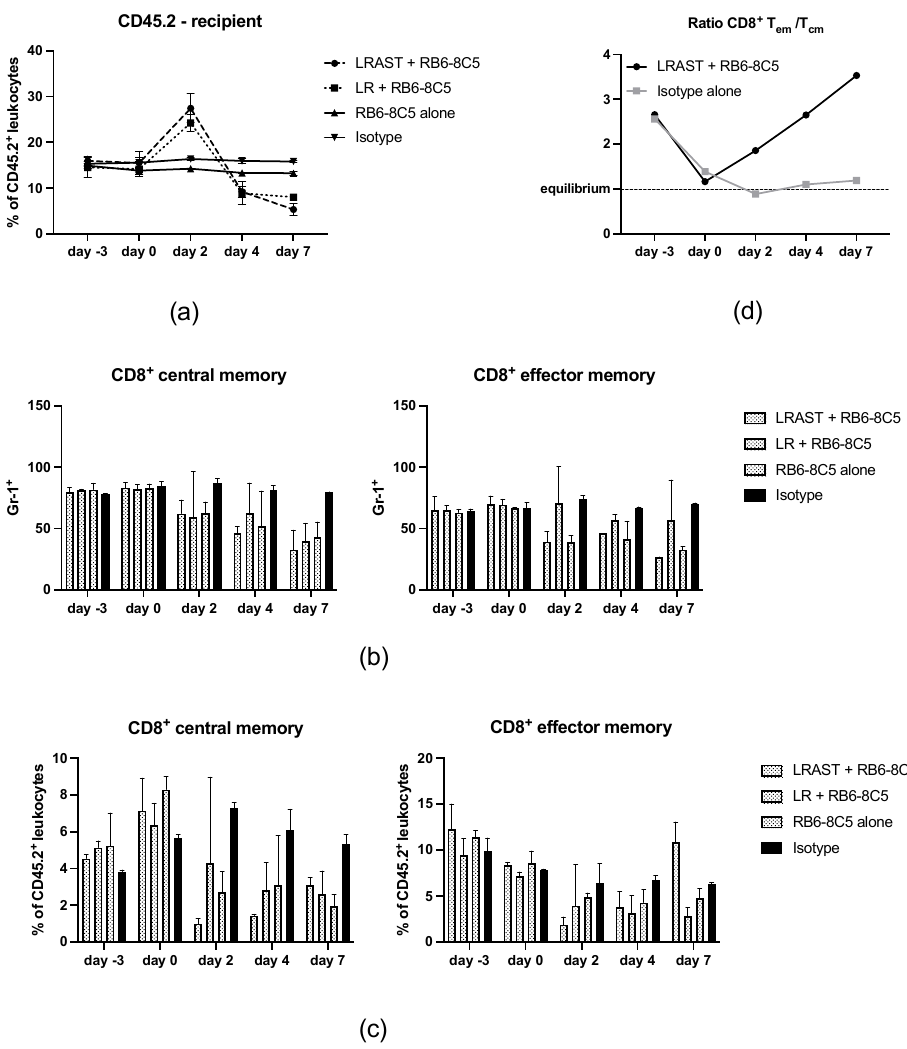
Figure 5. Effect of RB6-8C5 administration on CD8 + memory T cells . ( a ) Frequency of CD3 + CD8 + cells in % of CD45.2 + leukocytes (in the following referred to as CD8 + cells), assessed by flow cytometry on days -3, 0, 2, 4, and 7 from the blood of mice in different treatment groups (as indicated in the picture). ( b ) Frequency of Gr-1 + CD8 + central (left) and effector (right) memory T cells from the same animals as in ( a ). ( c ) CD8 + central (left) and effector (right) memory T cells in % of CD45.2 + leucocytes form the same animals as in ( a ). ( d ) Ratio of CD8 + effector and central memory T cells (T em /T cm ) calculated from results depicted in (c). A ratio equal to 1 represents an equilibrium state with identical amounts of both memory T cell subsets. ( a – d ) n = 2 per group. Data are means with SD.